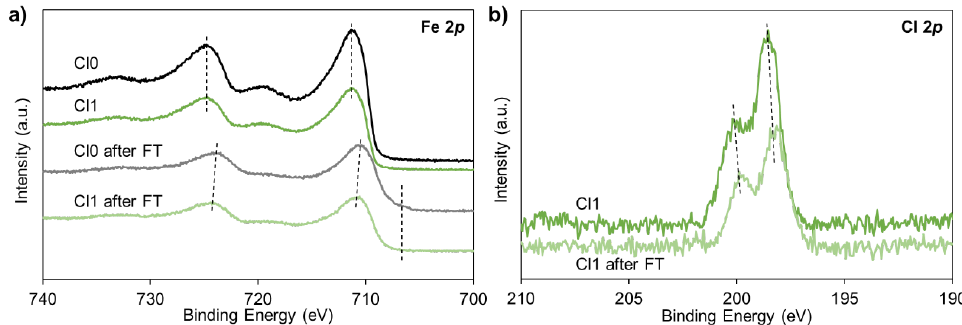
Figure 7. XPS spectra of Cl0 and Cl1 catalysts; ( a ) are spectra of Fe 2p and ( b ) are spectra of Cl 2p.